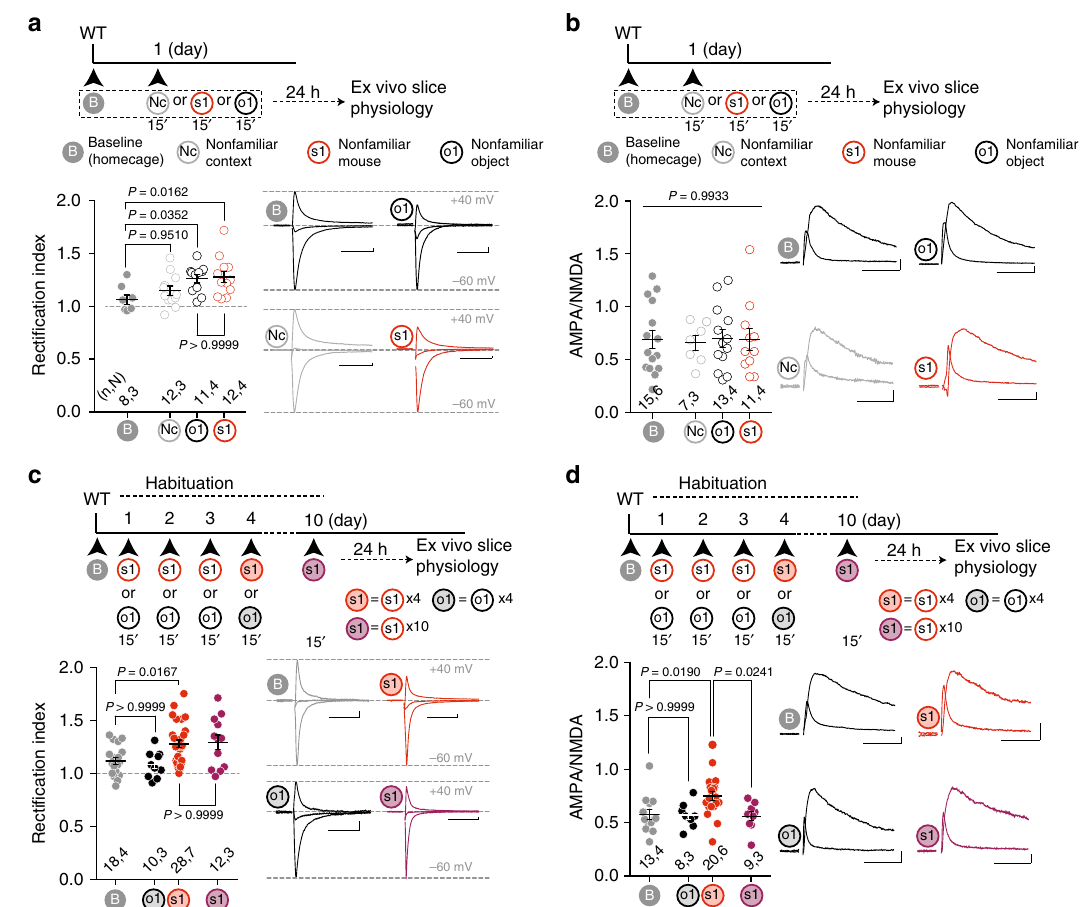
Fig. 6 Novelty-induced synaptic plasticity. a Top: experimental paradigm. Bottom: scatter plot of recti fi cation index and AMPAR-EPSCs example traces ( − 60, 0, and 40 mV) recorded from VTA DA neurons at baseline (B, homecage), or 24 h after 15 min of novel context (Nc), nonfamiliar conspeci fi c (s1) or novel object (o1) exposure. One-way ANOVA ( F (3, 39) = 4.153, P = 0.0120) followed by Bonferroni post hoc test for planned comparisons. b Top: experimental paradigm. Bottom: scatter plot and example traces of AMPA/NMDA ratio recorded from VTA DA neurons at baseline (B, homecage), or 24 h after 15 min of novel context (Nc), nonfamiliar conspeci fi c (s1) or novel object (o1) exposure. One-way ANOVA ( F (3, 42) = 0.0287, P = 0.9933). c Top: experimental paradigm. Bottom: scatter plot and example traces of recti fi cation index recorded from VTA DA neurons at baseline (B), 24 h after four repeated exposures to either a novel mouse (s1) or a novel object (o1) and ten repeated exposures to a nonfamiliar conspeci fi c (s1, bold purple). One-way ANOVA ( F (3, 64) = 5.149, P = 0.0030) followed by Bonferroni post hoc test for planned multiple comparisons. d Top: experimental paradigm. Bottom: scatter plot and example traces of AMPA/NMDA ratio recorded from VTA DA neurons at baseline ( b ), 24 h after four repeated exposures to either a nonfamiliar conspeci fi c (s1) or a novel object (o1) and ten repeated exposures to a nonfamiliar conspeci fi c (s1, bold purple). One-way ANOVA ( F (3,46) = 4.4939, P = 0.0076) followed by Bonferroni post hoc test for planned multiple comparisons. n , N indicates number of cells and mice respectively. Scale bars: 20 msec, 20 pA. Error bars report